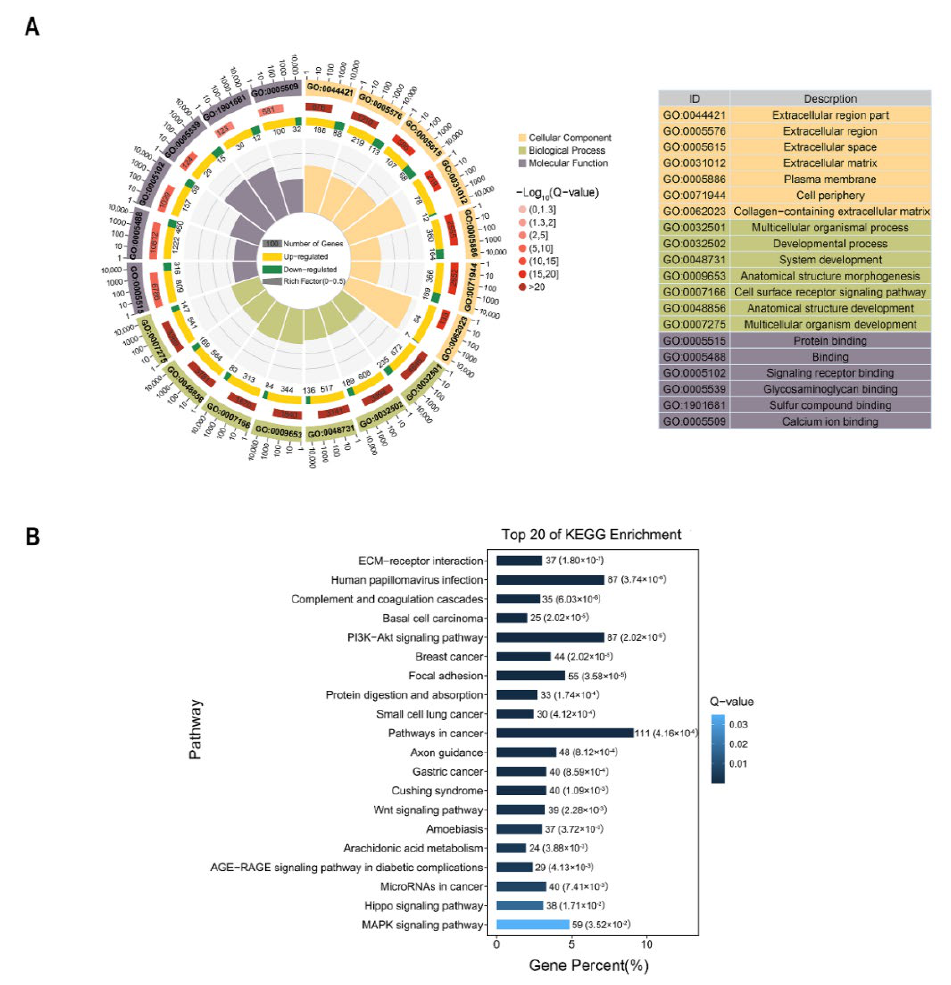
Figure 4. Functional annotation and enrichment analysis for differentially expressed (DE) mRNAs in the mammary glands of the lactating and nonlactating groups. ( A ) GO annotation results of DE mRNAs. The outermost circle shows the items most significantly enriched among the DE mRNAs. The second circle indicates the number of background DE mRNAs and the levels of Q-values. The third circle, consisting of bar graphs, shows the ratio of upregulated DE mRNAs to downregulated ones associated with each GO term, in which yellow represents the upregulated portion and green indicates the downregulated portion. The innermost (fourth) circle indicates the rich factor value for each GO term (the number of DE mRNAs versus the number of non-DE mRNAs associated with the GO term). Each gridline represents 0.1. ( B ) Top 20 significant pathways of KEGG enrichment analysis of DE mRNAs. The ordinate is the pathway, and the abscissa is the enrichment fac- tor.